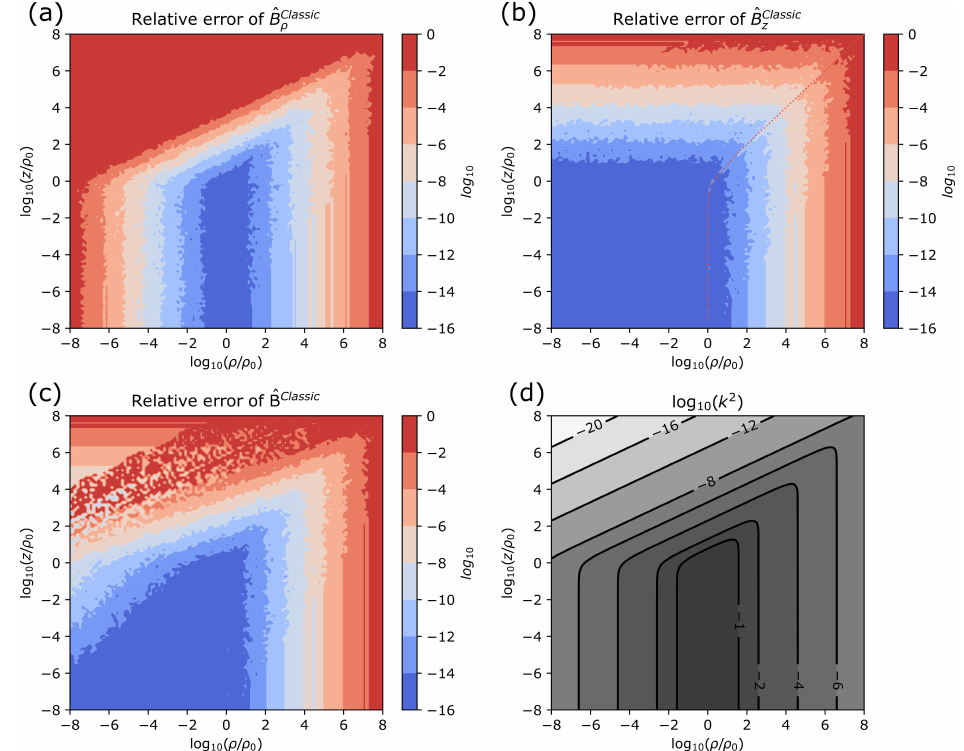
Figure 3. Relative error of a straightforward implementation of the textbook expressions for the B -field of a current loop. ( a ) Radial and ( b ) axial components, as well as ( c ) vectorwise analysis reveal a high level of numerical instability. ( d ) The relation between the cylindrical coordinates and the important quantity k .